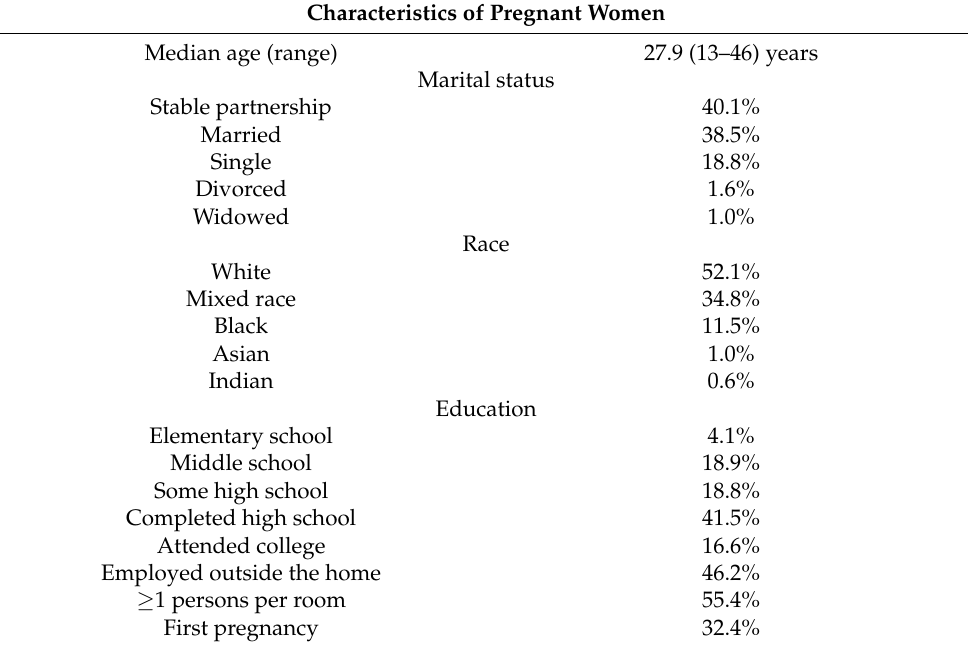
Table 1. Characteristics of total study